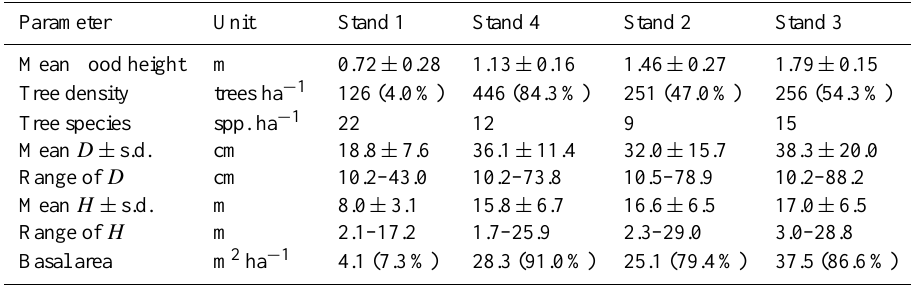
Table 1. Stand parameters of trees ≥ 10cm D in four 1-ha stands in the Pantanal (s.d.: standard deviation). Numbers in brackets indicate relative numbers for V. divergens .